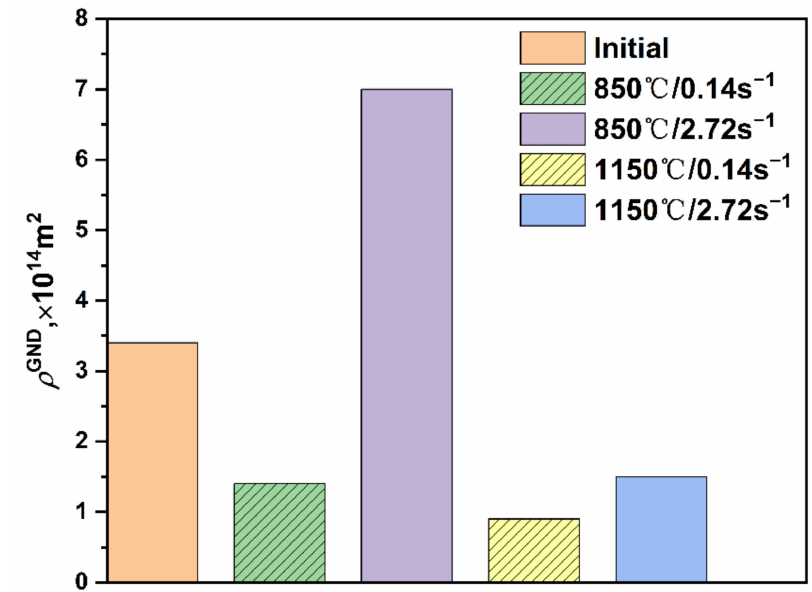
Figure 12. The GND densities of the studied nickel-based alloy